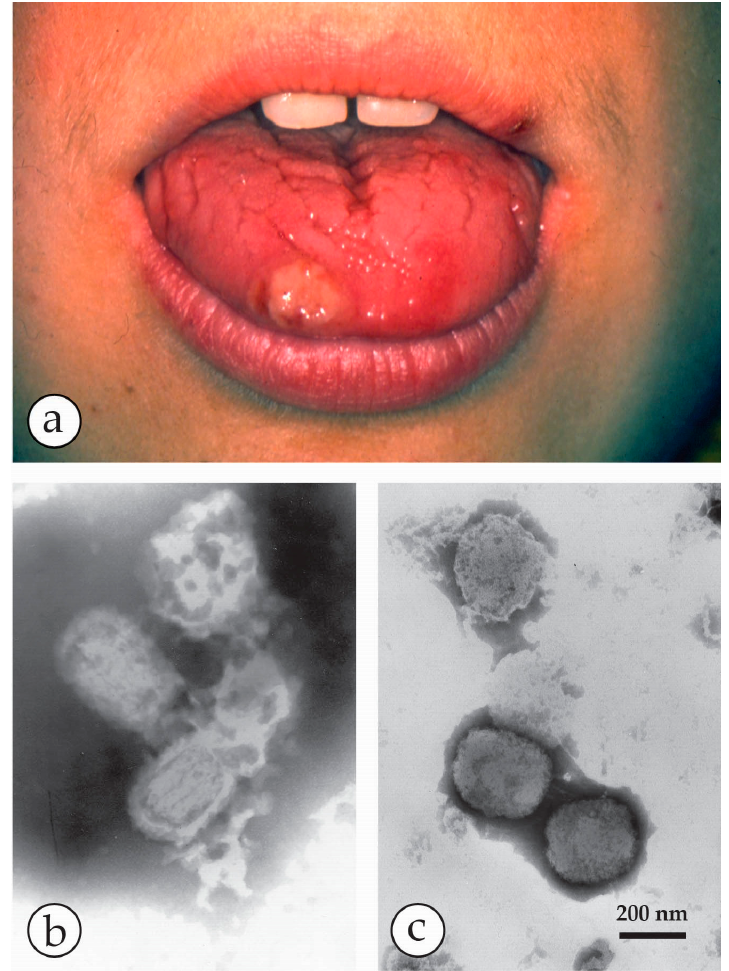
Figure 15. An unexpected result: ( a ) A presumed syphilitic lesion on the tip of the tongue of a young mother. When dark field light microscopy repeatedly failed to reveal Treponema pallida , doubts